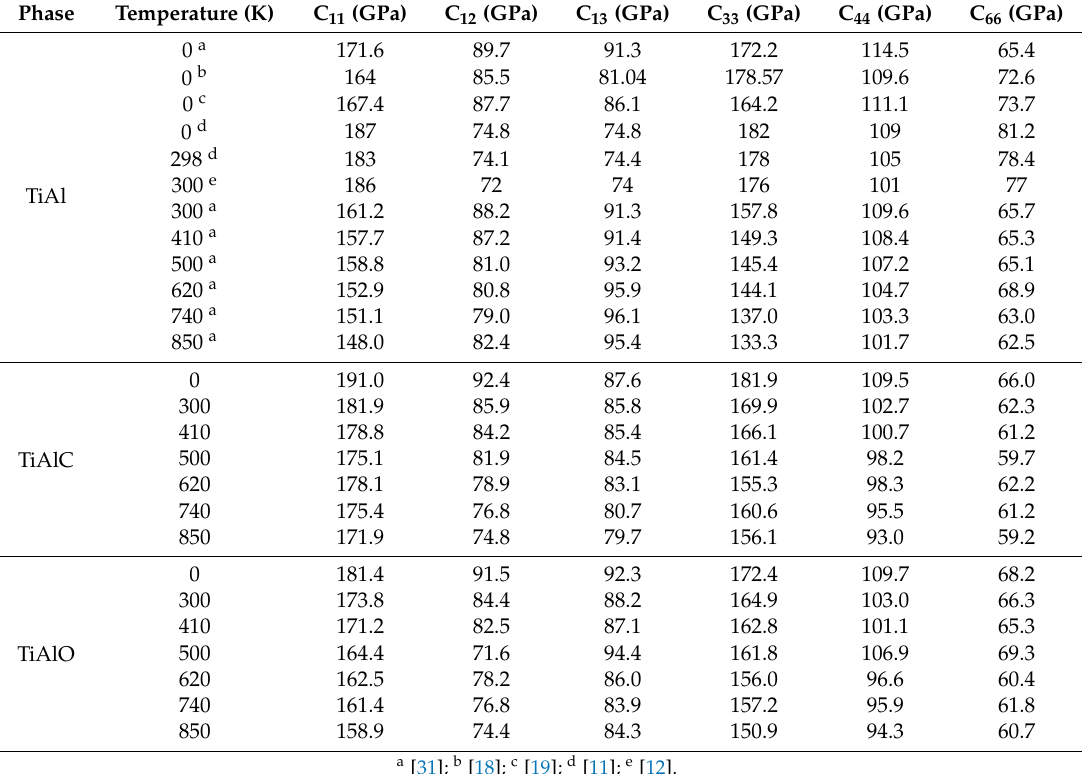
Table 1. The calculated elastic constants of TiAlC and TiAlO at different temperatures.